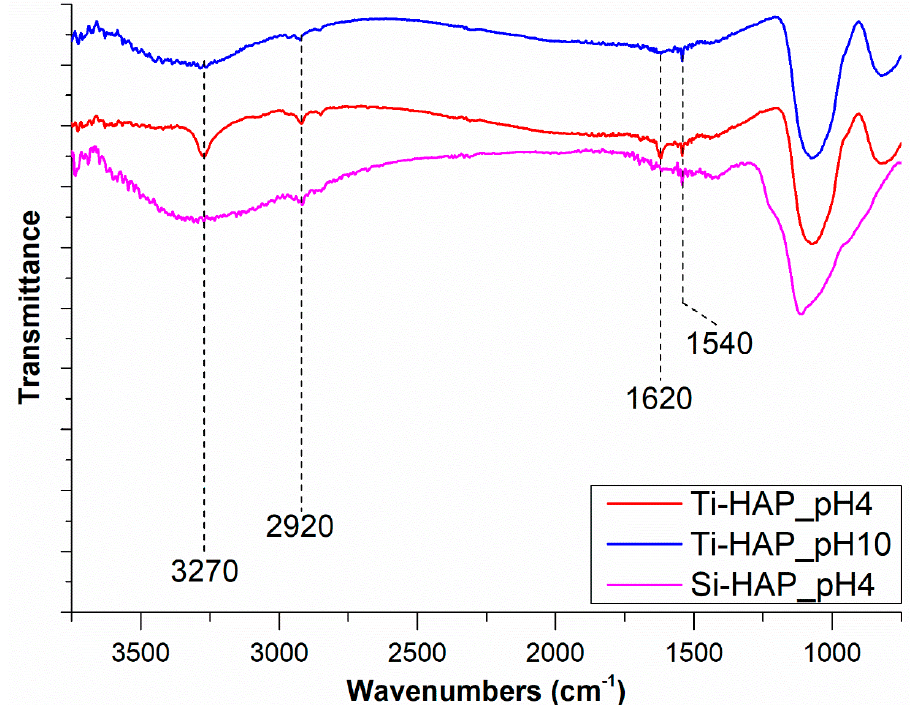
Figure 4. FTIR spectra in the 4000–800 cm − 1 region of samples Ti-HAP and Si-HAP, after incubation in SAP solutions at di ff erent pH